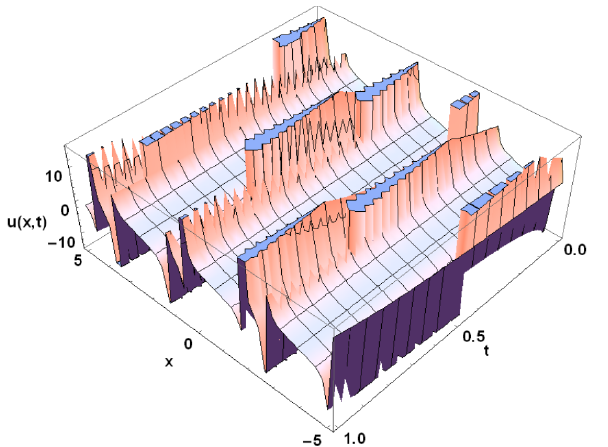
Figure 2. ( a , b ): Graphical analysis of Equation (23) for the values of the parameters A = 2, 3,